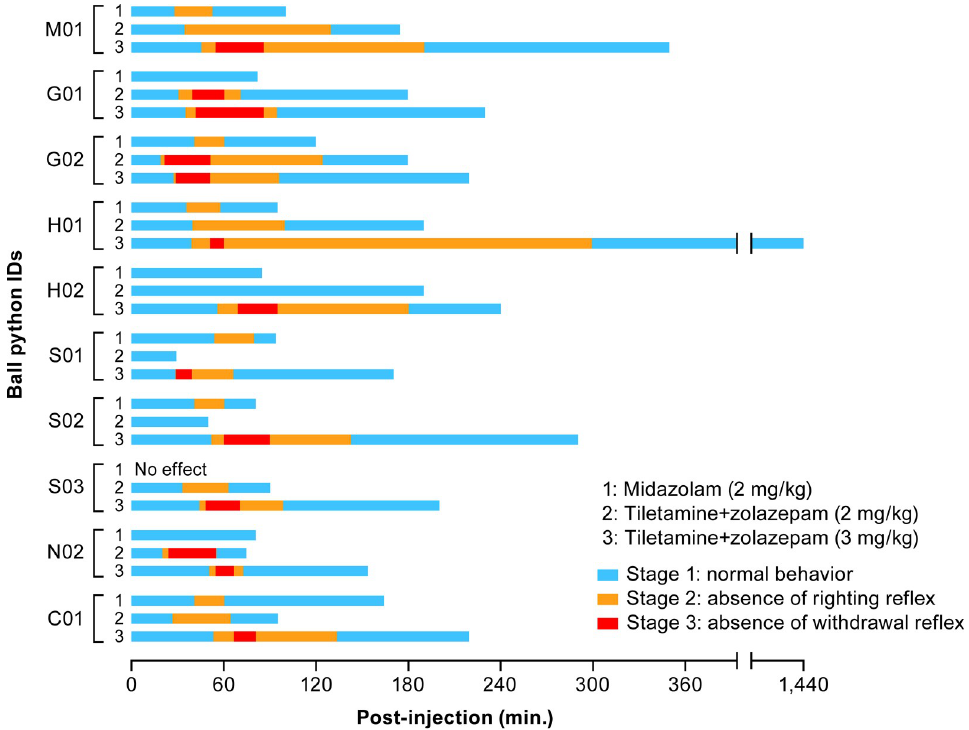
Fig 1. Evaluation of the depth of anesthesia in ball pythons following injection of midazolam or a fixed combination of tiletamine+zolazepam. Each snake was graphed chronologically through the stages of anesthesia experienced by the animal after intramuscular injection of midazolam (2 mg/kg), tiletamine+zolazepam (2 mg/kg), or tiletamine+zolazepam (3 mg/kg). Time spent in each anesthetic stage is displayed by colored bars. The duration of anesthesia of snake H01 following administration of 3 mg/kg of tiletamine+zolazepam is denoted by an interrupted X axis. Snake H01 did not return to normal behavior until 1,440 min post-injection.